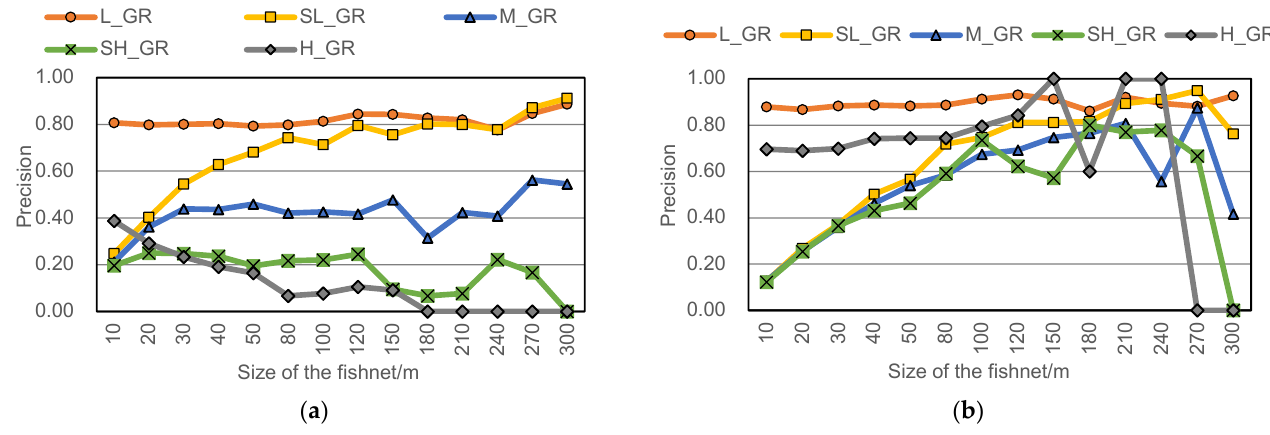
Figure 2. The precision of GR grades between GF1 and DJI ( a ) and that between GF1 and S2A ( b ).